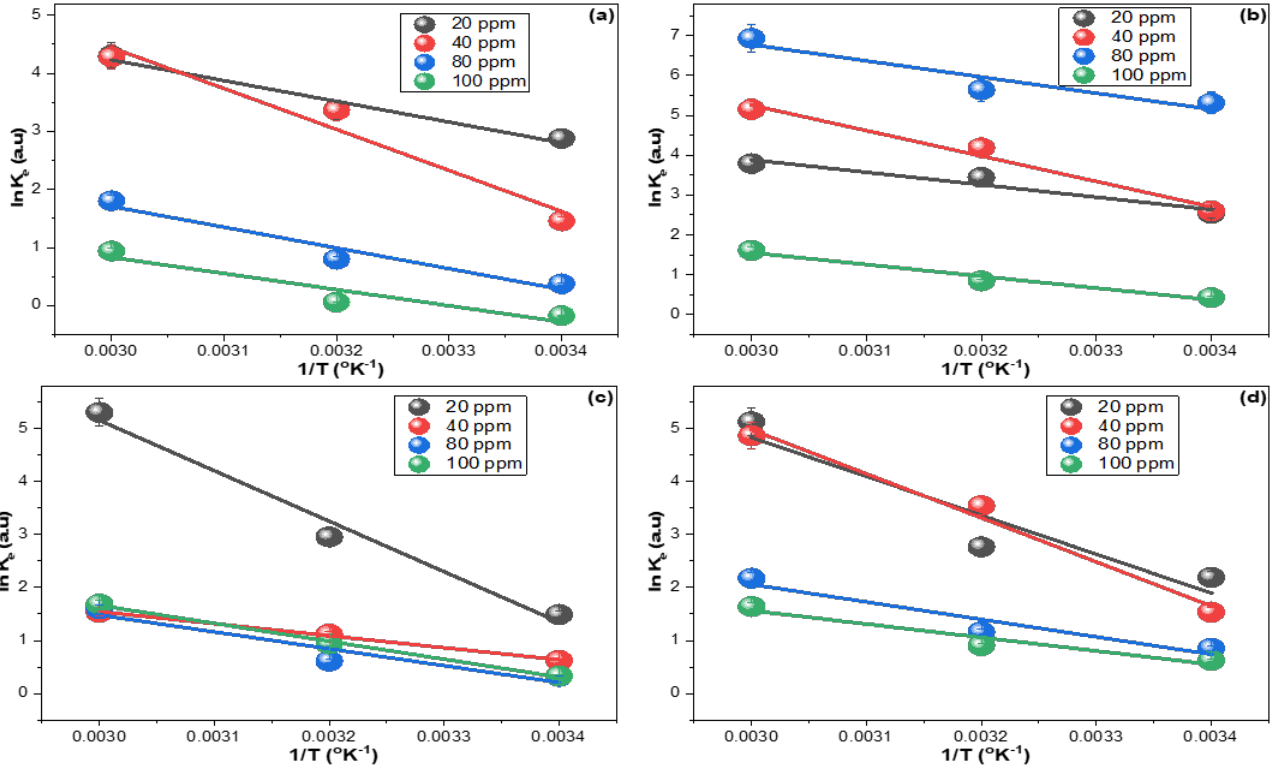
Figure 8. Thermodynamics study of the sorption of ( a ) TGCN, ( b ) DXCN, ( c ) CTCN, and ( d ) OTCN on the synthesized CRNPs at 298, 313, and 328 °K by utilizing 20, 40, 80, and 100 mg L −1 as fed concentrations.